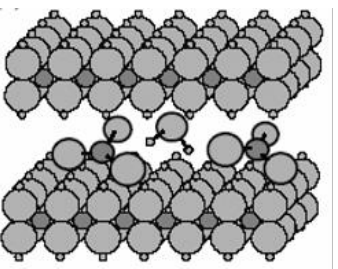
Figure 1. Typical structure of nanoceramics, i.e., metal hydroxide layers and interlayer anions